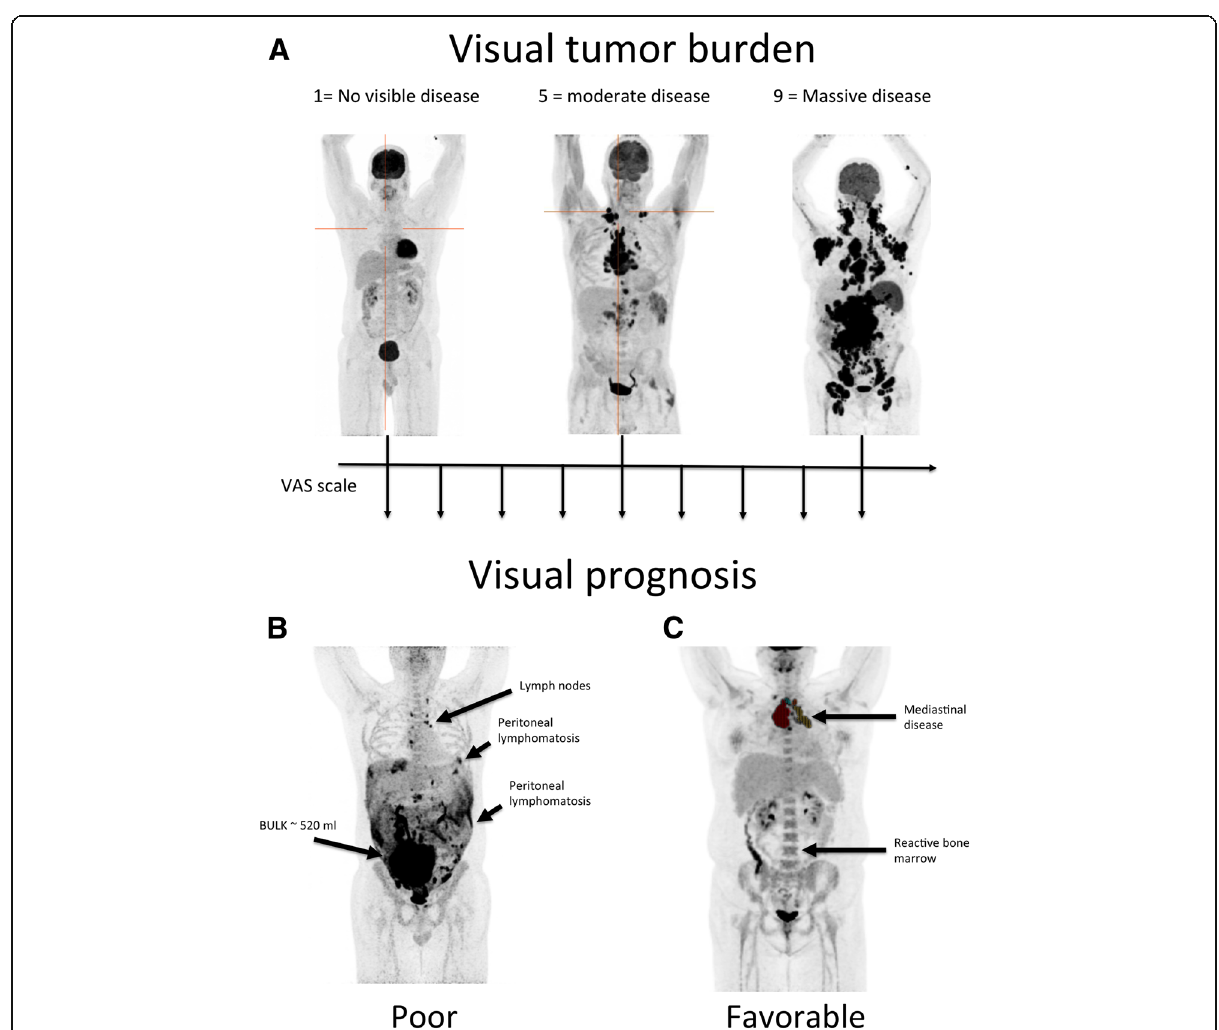
Fig. 1 Metabolic tumor burden assessed on a VAS scale with representative examples of patients graded as 1, 5, and 9 ( a ). All reviewers used these examples to grade individual cases in the study. b An example of a patient with a poor prognosis based on the widespread peritoneal lymphomatosis, bulky disease, and high metabolic tumor volume. Pointedly, the peritoneal lymphomatosis may be difficult to accurately quantify using semi-automatic tumor delineation tools whereas the severity of disease is readily perceived by visual inspection using a maximum intensity projection FDG PET/CT. c A patient with limited mediastinal disease used as an example of a patient with favorable